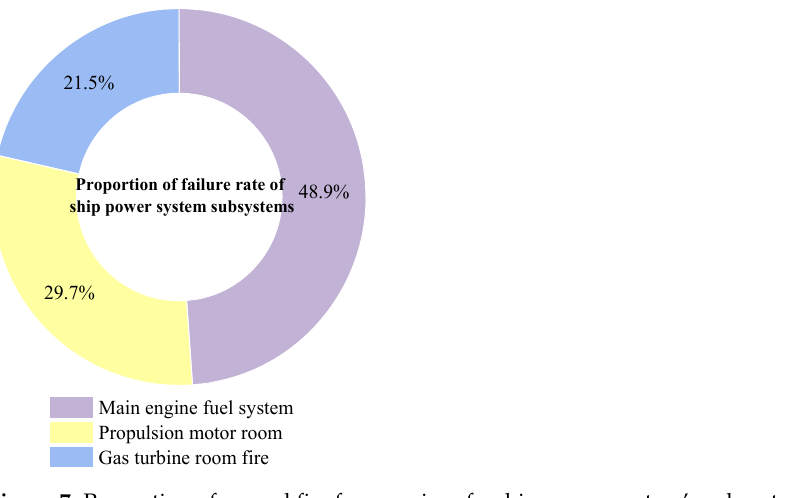
Table 12. The annual fire frequencies and safety risk indexes of the subsystems.